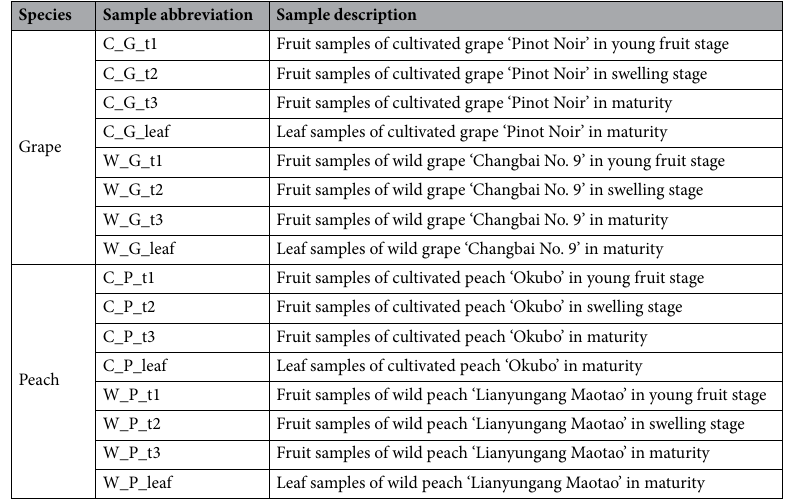
Table 1. Sample abbreviation specifications.